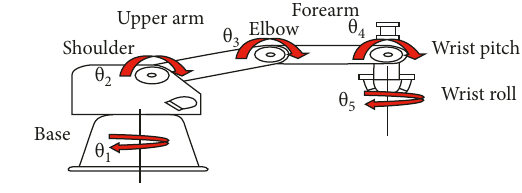
Figure 1: 5 DOF articulated robot.